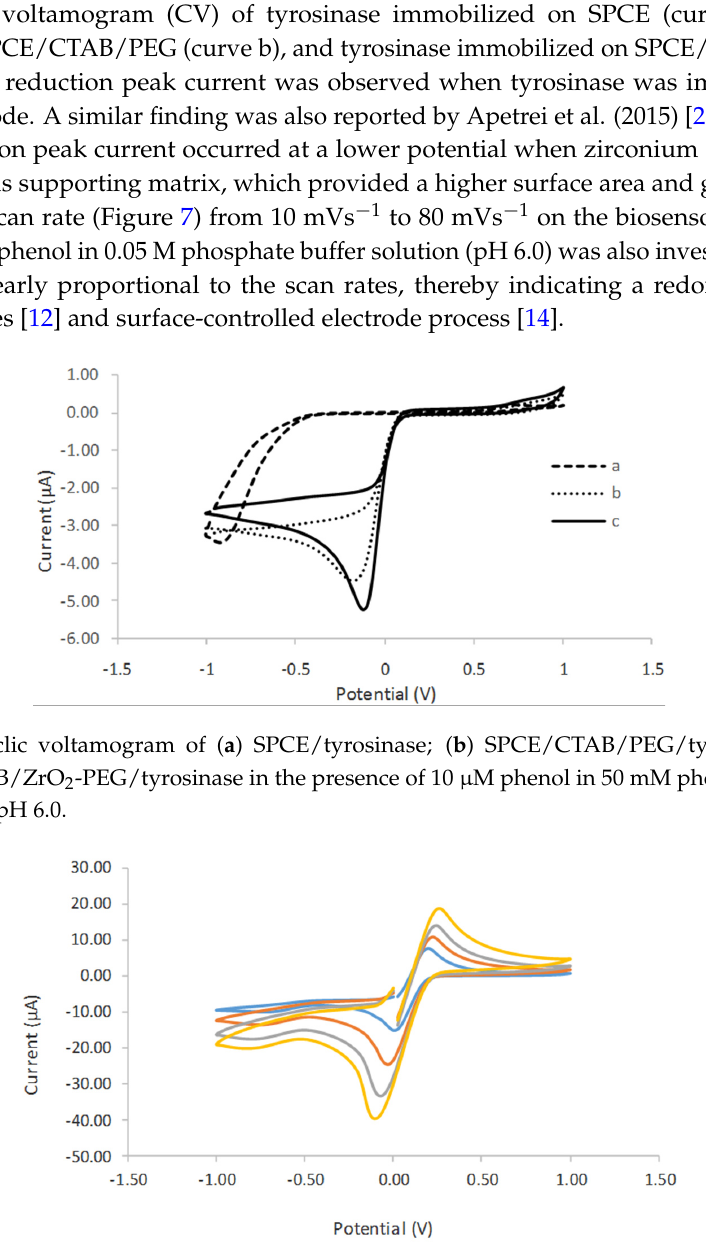
Figure 7. Cyclic voltamogram study on the effect of the scan rate from 0.01 V/s until 0.09 V/s in 5.0 mM K 4 Fe(CN) 6 containing 0.1 M KCl as a supporting electrolyte. 3.5. Optimization of Experimental Parameters